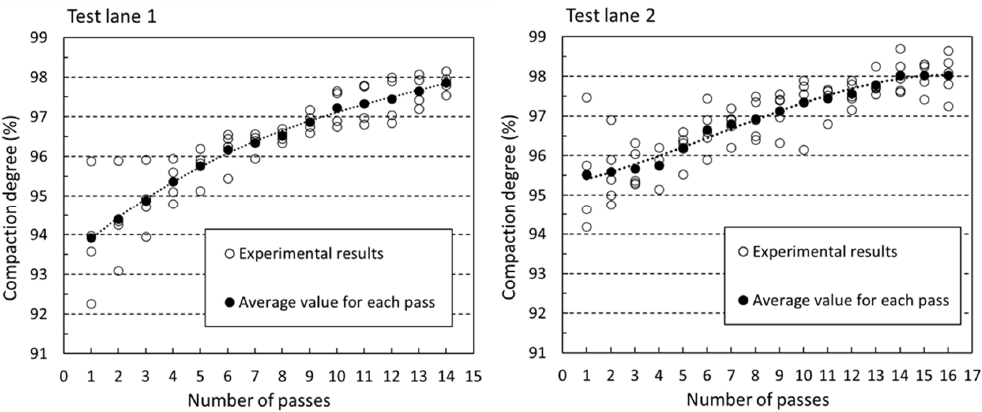
Figure 5. Relationship between the number of passes and degree of compaction.